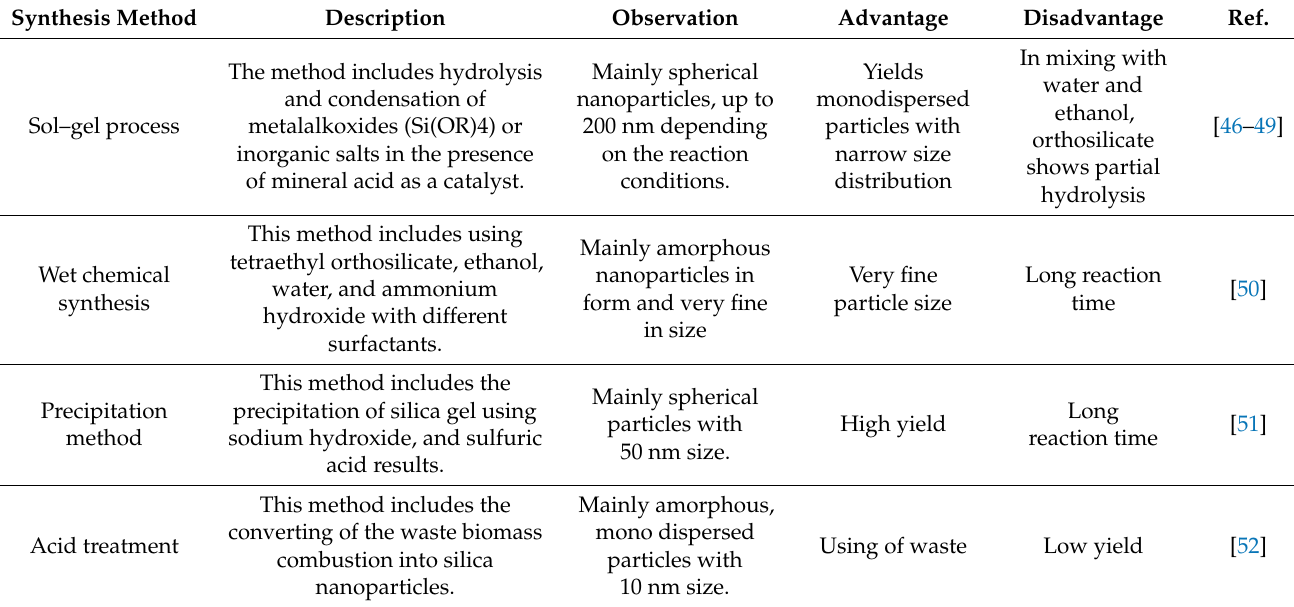
Table 2. Methods to prepare the silica nanoparticles.